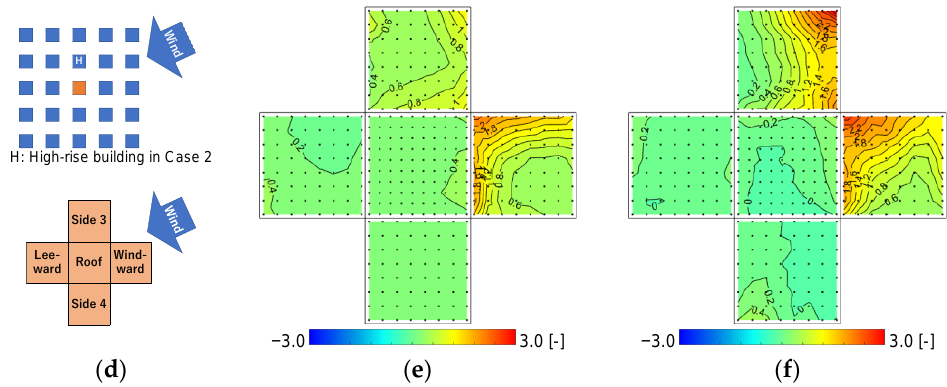
Figure 13. Positive 𝑝𝑒𝑎𝑘𝐶 𝑝 ; ( a ) building model arrangement and prevailing wind direction for ( b , c ); ( b ) wind direction of 0° in Case 0 with no high-rise building; ( c ) wind direction of 0° in Case 2 with a high-rise building next to the pressure measurement model; ( d ) building model arrangement and prevailing wind direction for ( e , f ); ( e ) wind direction of 65° in Case 0; ( f ) wind direction of 65° in Case 2. side of the ground surface on side 1.